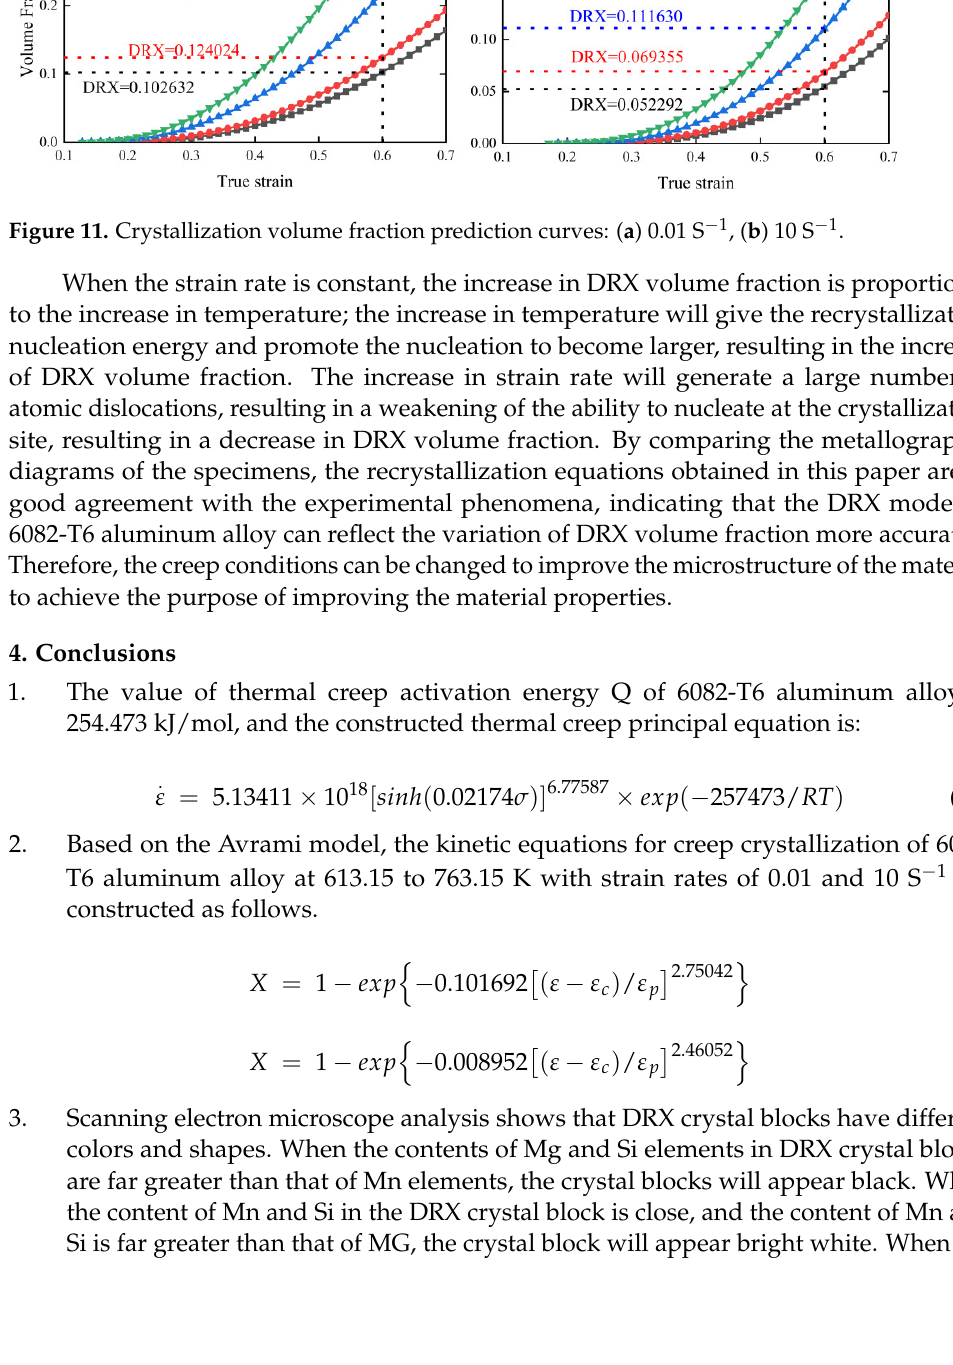
The predicted creep recrystallization volume fraction curves for 6082-T6 aluminum alloy at strain rates of 0.01 and 10 S −1 are shown in Figure 11, based on the kinetic equations